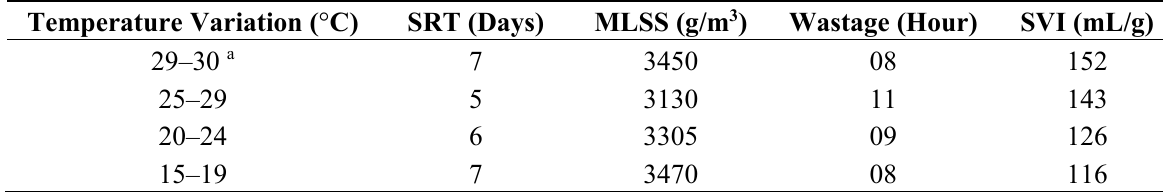
Table 3. Effect of Temperature on sludge volume index